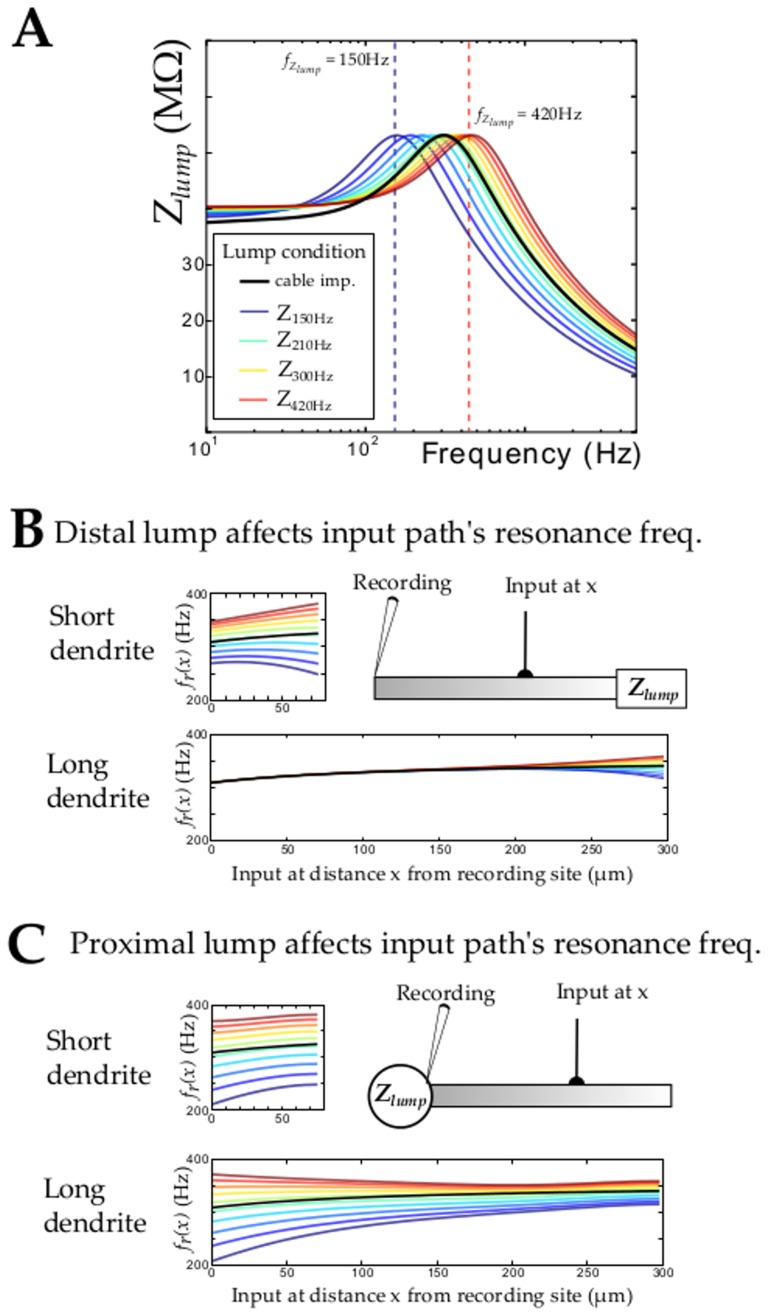
Effect of boundary conditions on the spatial profile of resonance frequencies observed in a dendritic segment.A. To explore the effect of boundary conditions on a dendritic segment, different resonant lumped boundary conditions, , are used. The color-code represents resonance frequency of the “lumped” boundary condition with blue to red corresponding to resonance frequencies ranging lower to higher than the cable characteristics –black line. B. A resonant boundary condition at the tip of a cable mimics sudden changes in membrane parameters and can represents as a first approximation either a change in channel density between segment of a in non-uniform cable or local geometric changes (branching or tapering). The influence of the resonant boundary condition is obtained analytically in the case of this simple abstract morphology. The spatial profile of resonance is shown for the different conditions presented in A. The spatial profile of resonance is influenced over its entire length in the case of short segments (75 µm -upper panel) while long segment (300 µm – lower panel) are affected mostly on their distal tip when compared to the refence case of a semi-infinite cable. C. Similarly, the spatial profile of resonance is drastically changed when a resonant boundary condition is located at the soma. The effect is large and observed over the entire resonant segment, even when the segment is long. This has important implication for e.g., stellate cells for which each dendritic branch “sees” at its proximal ending a resonant “lumped” boundary condition constituted of the soma and all other branches.